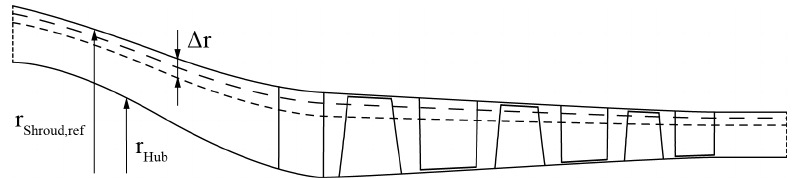
Figure 2. Low-pressure compressor (LPC) for three different BPRs (17, 20, 25).